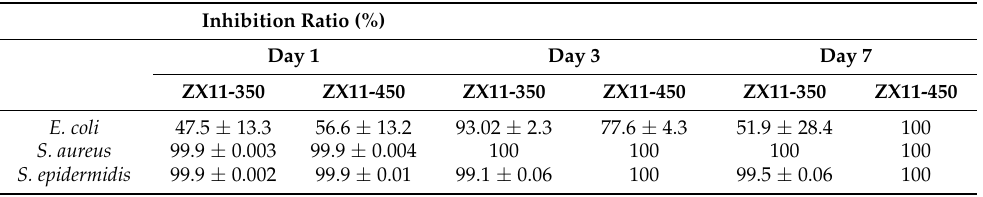
Table 3. Antibacterial effect (inhibition ratio percentage) of the ZX11 alloy against E. coli , S. aureus , and S. epidermidis . Data are presented as mean ± standard error of the mean (SEM). Inhibition Ratio